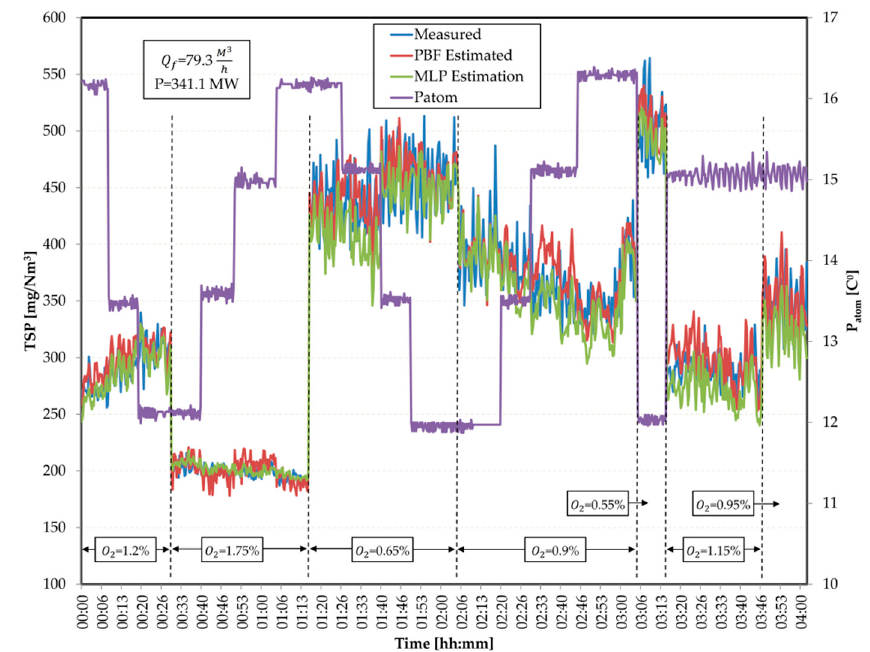
Figure 7. Measured (validation subset) and estimated TSP with the PBF and MLP models.